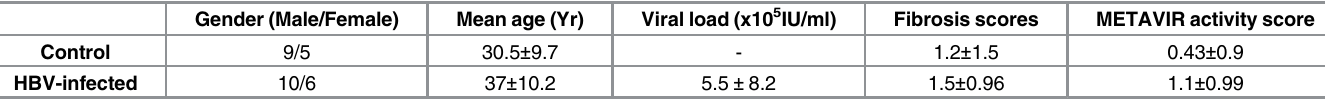
Table 1. Characteristics of the study population. Chronic HBV-infected patients (n = 16) and Control individuals (n = 14) were included in the study. Gender